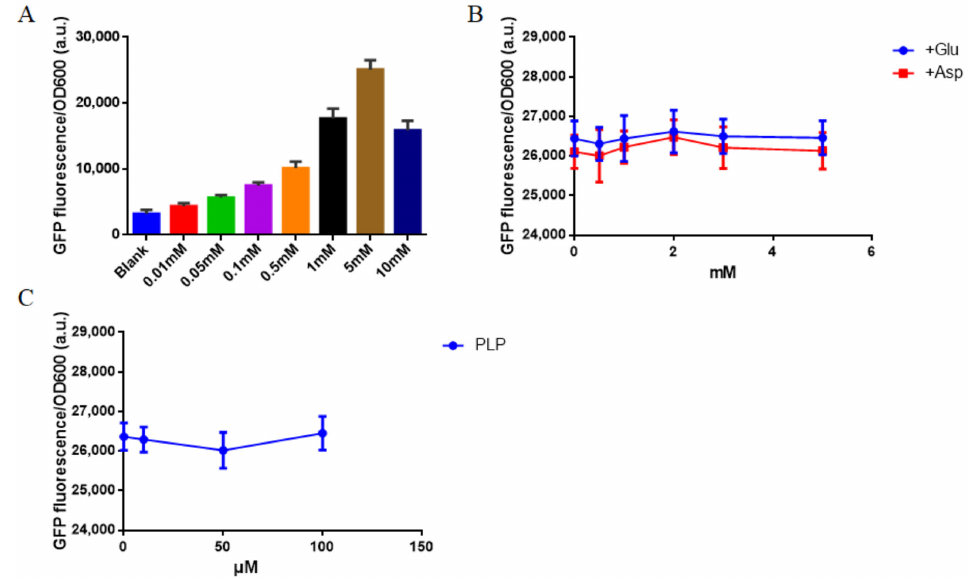
Figure 3. Optimizing the conditions for incorporation of the ncAA into eGFP using E. coli DH10B. Various concentrations of p -MeO-PPA were added to the medium ( A ), giving the highest expression efficiency at 5 mM. Addition of Glu or Asp as amino donor ( B ) or addition of PLP ( C ) had no effect on the total EGFP fluorescence intensity. The data are presented as mean ± SD of triplicate experiments. Generally, the transamination of phenylpyruvate requires the participation of pyri- doxal 5 (cid:48) -phosphate (PLP) as a cofactor, and an amino donor, such as Glu or Asp, can also